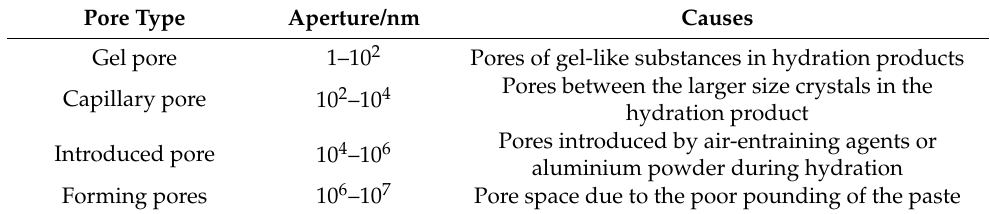
Table 5. Types and the ranges of pores in hardened